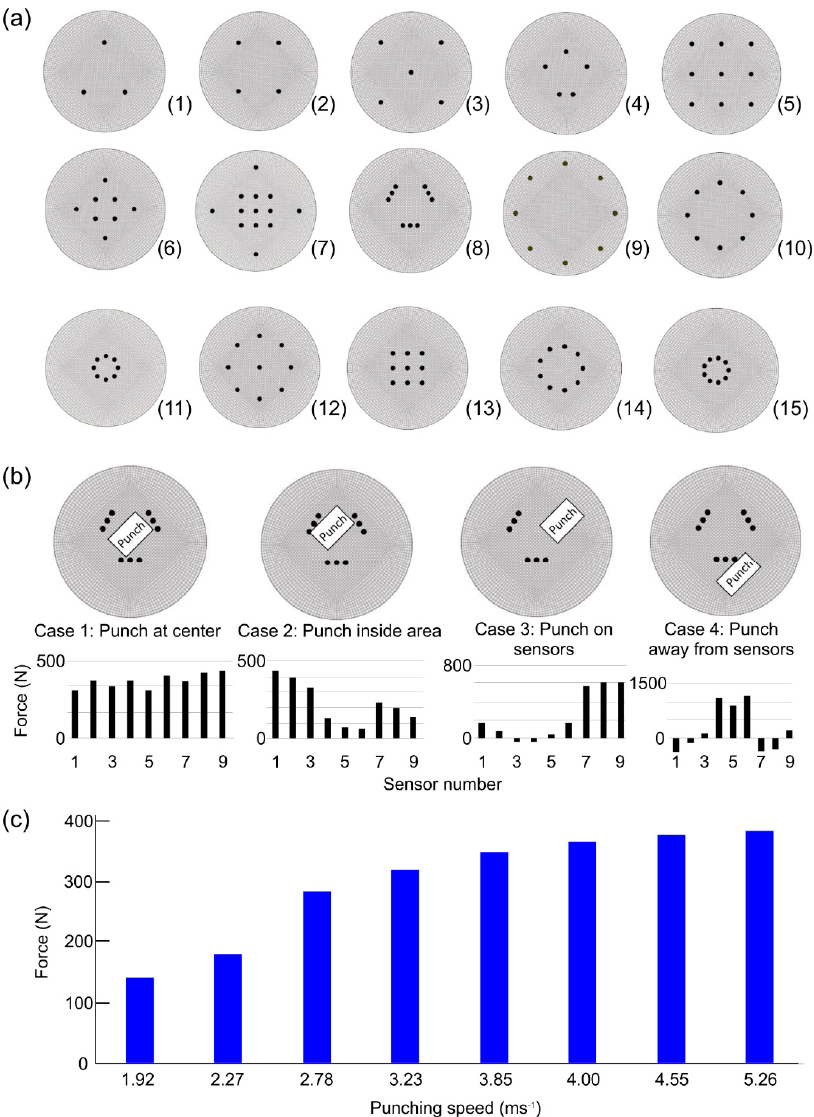
Figure 3. ( a ) The simulation of the different sensor configurations, ( b ) sensor force readings when punched on different areas on the wooden plates, ( c ) speed and corresponding force values of the gyaku tsuki punches.